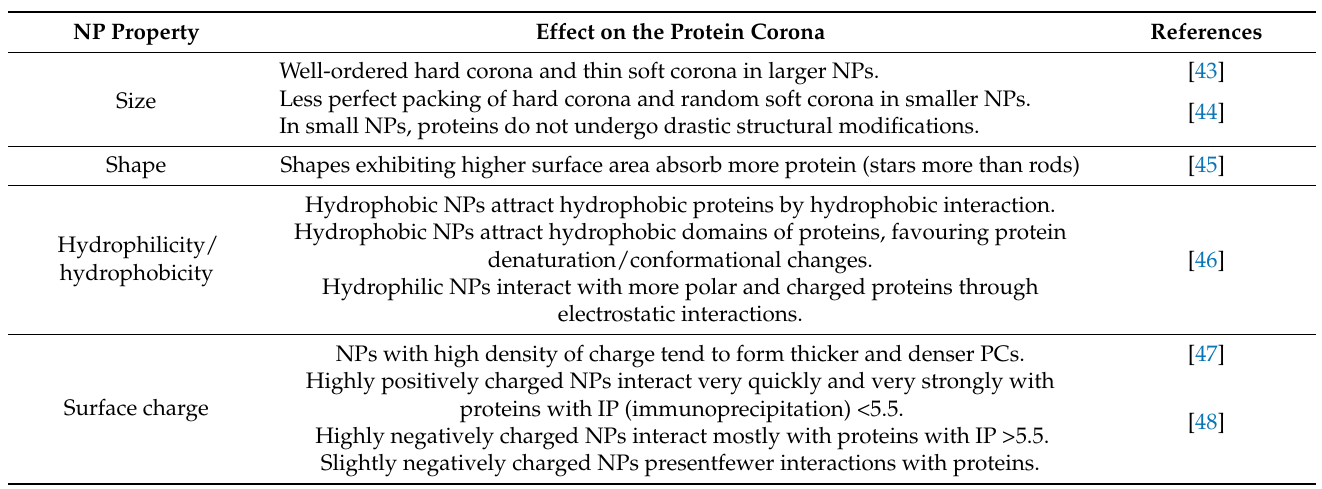
Table 1. Effect of the NP physicochemical properties onthe generation of the Protein Corona. Adapted from [20].